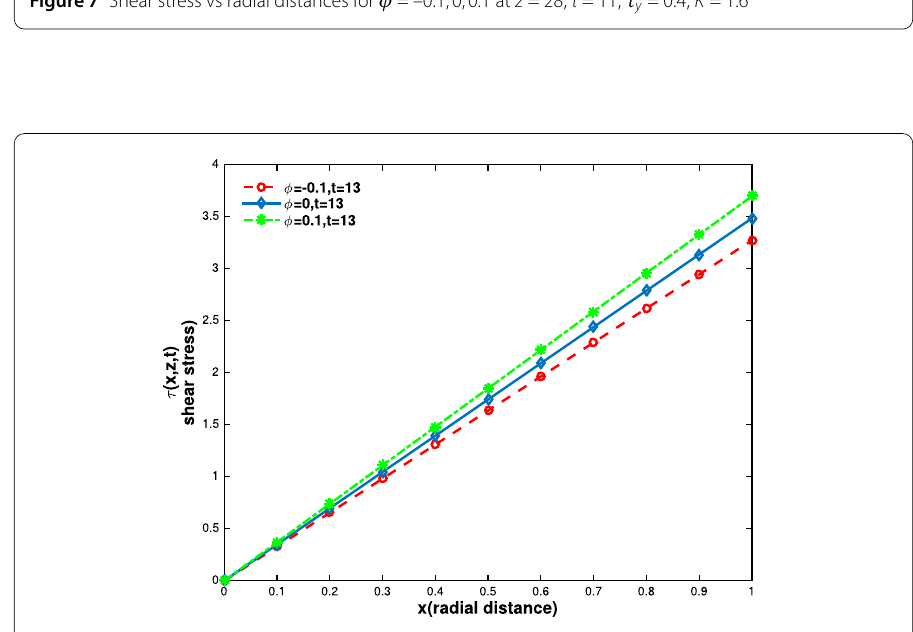
Figure 8 Shear stress vs radial distances for φ = –0.1,0,0.1 at z = 28, t = 13, τ y = 0.4, K =